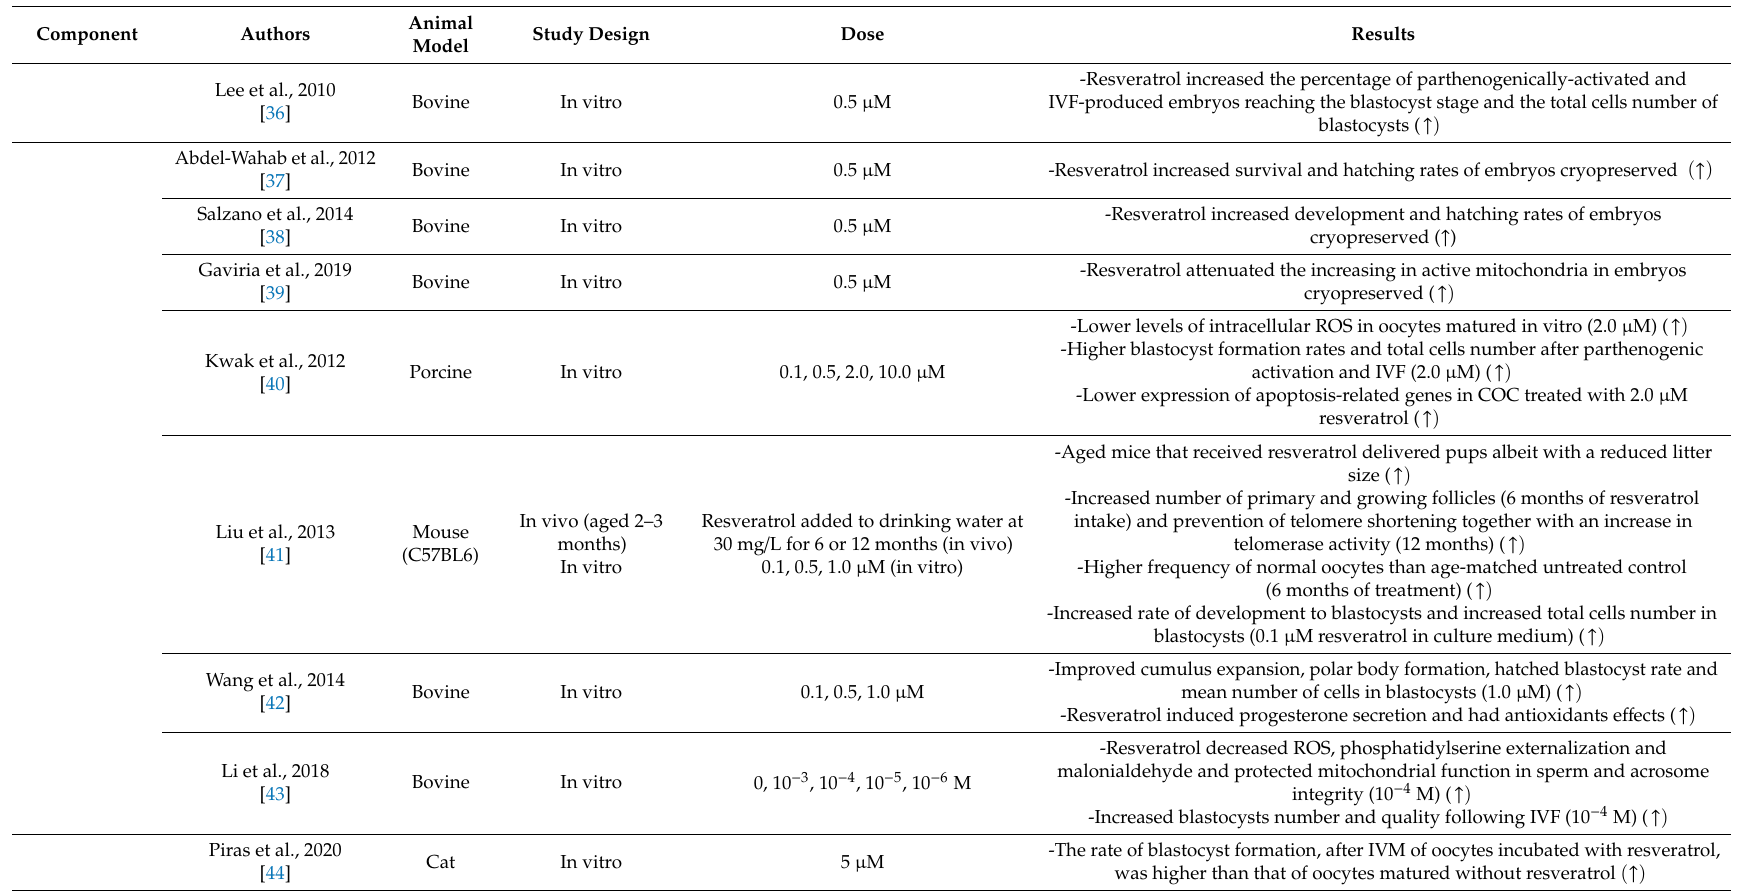
Table 1. In vitro and in vivo studies about antioxidants and vitamins in in vitro